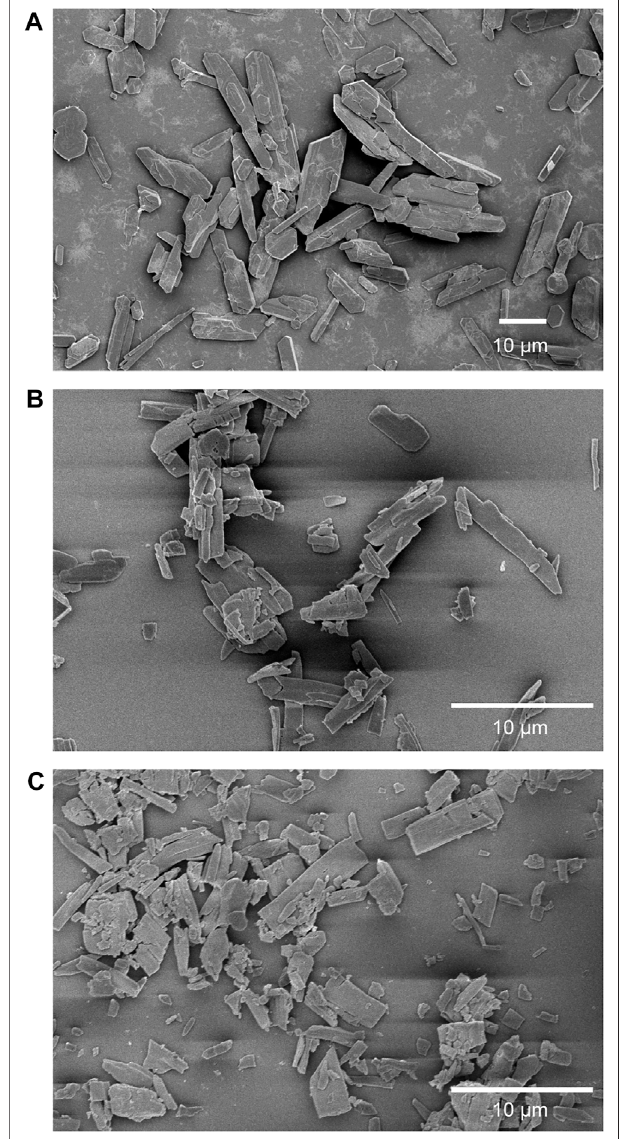
FIGURE4| SEMimages of (A) as-synthesizedpre-ELM-11 particles (a), (B) particles after the water adsorption measurement (b), and (C) particles after 10 cycles of air exposure and activation (d). The labels of a, b, and d correspond to those in Figure 1A .